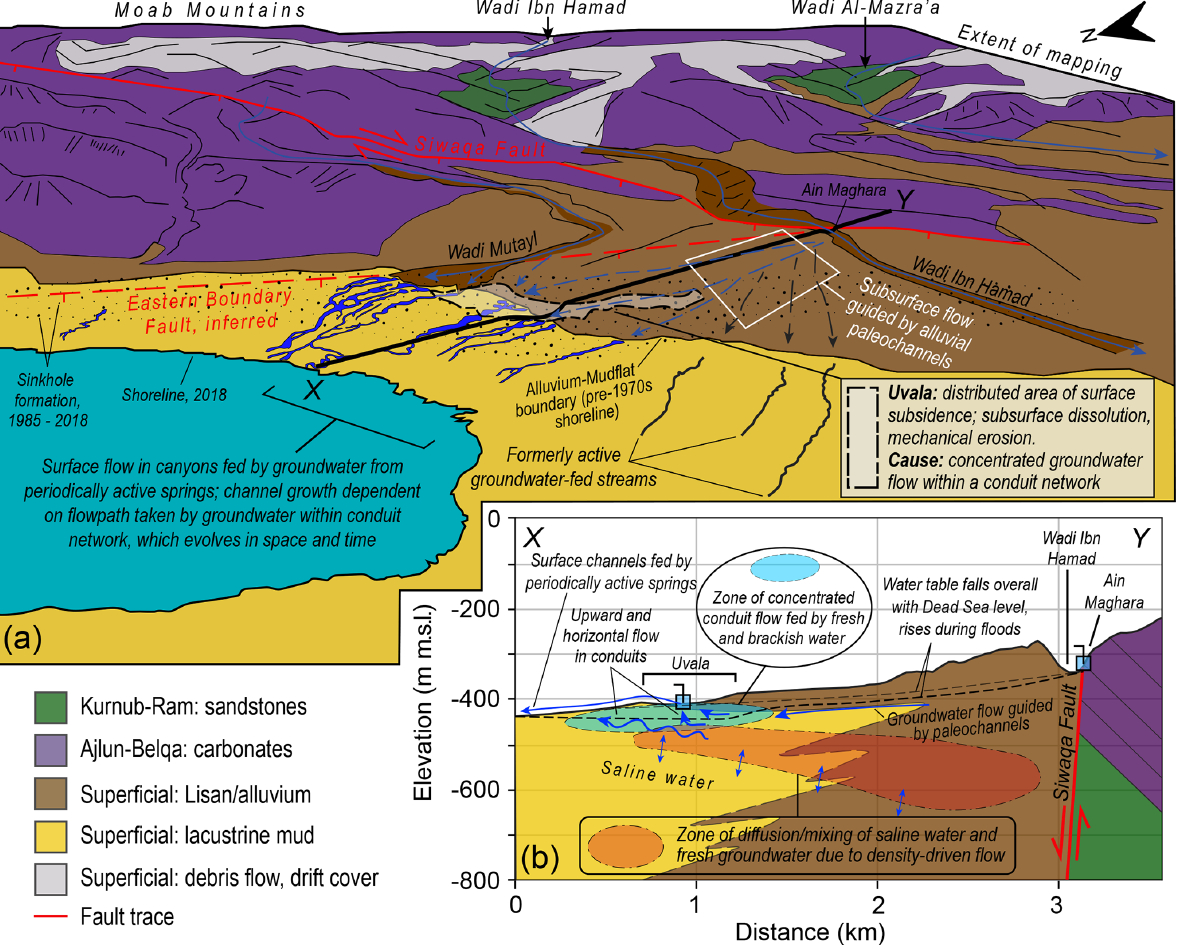
Figure 16. Conceptual model of the hydrogeological system at Ghor Al-Haditha. (a) Oblique aerial view sketch map (altitude of the eye is around 600m) showing the geological units as outlined in Sect. 2, based on Khalil (1992), structural geology, catchments of the major wadis and areas of surface flow observed in channels and inferred subsurface flow in buried paleochannels (in the alluvial fan deposits) and in a conduit network (below the uvala). Note that the locations of sinkholes are schematic and not as mapped by Watson et al. (2019). Line X–Y is the location of the cross section in part (b) , which shows the hydraulic structure of the subsurface as inferred from our geophysical studies and the hydrogeological